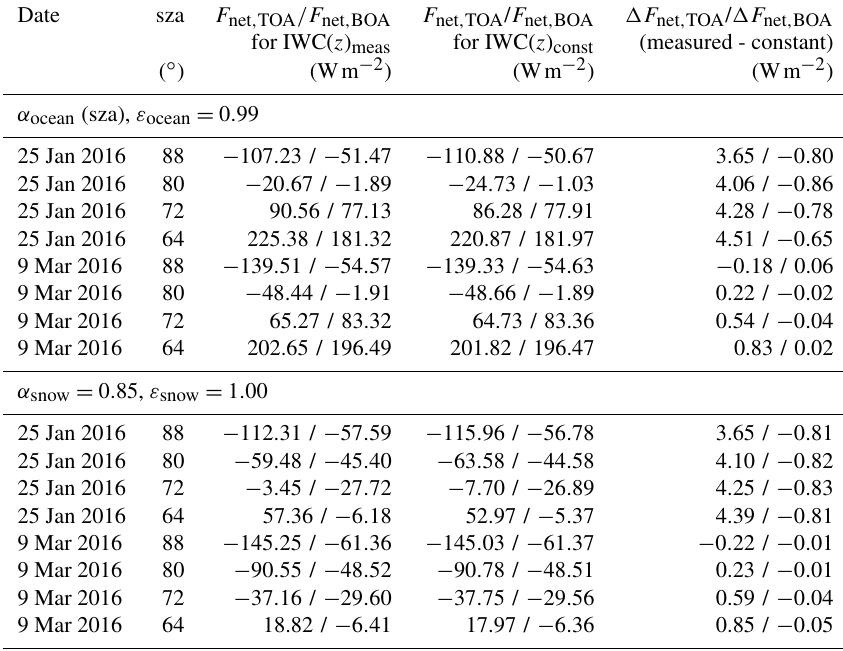
Table A1. The same as Table 2 but for ice clouds with higher optical thicknesses as a result of multiplying the entire profile IWC( z ) by a factor of 5. Date sza F net , TOA /F net , BOA F net , TOA / F net , BOA (cid:49)F net , TOA / (cid:49)F net , BOA for IWC( z ) meas for IWC( z ) const (measured - constant) ( ◦ ) (Wm − 2 ) (Wm − 2 ) (Wm − 2